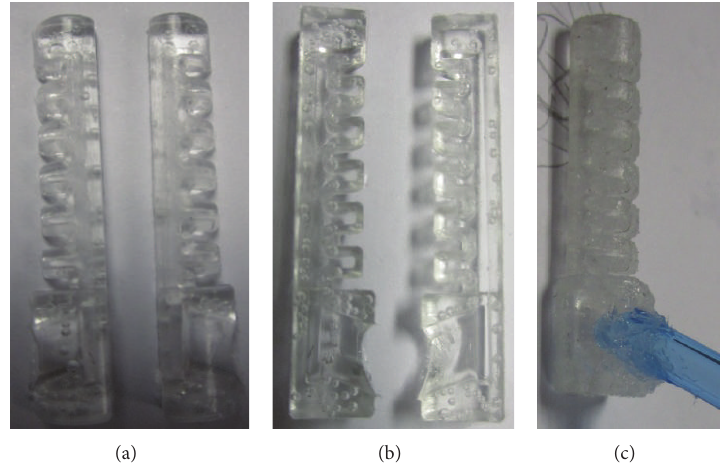
Figure 9: Manufactured parts of AFPA: (a) outside view, (b) inside view, and (c) complete actuator.